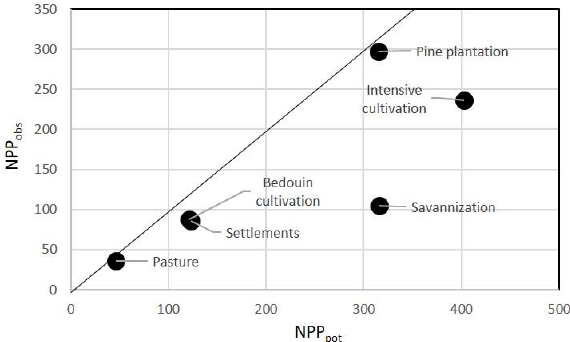
Figure 5. Modal values (columns) and ranges (bars) of ( a ) NPP obs , ( b ) NPP pot , ( c ) LNS diff , and ( d ) LNS % , in gC m −2 yr −1 . Bars indicate the upper and lower inflection points in the frequency distributions—not confidence limits. Land Use Types: 1, Savannization; 2, Intensive Cultivation; 3, Bedouin Cultivation; 4, Pine Plantation; 5, Pasture; 6, Settlements.